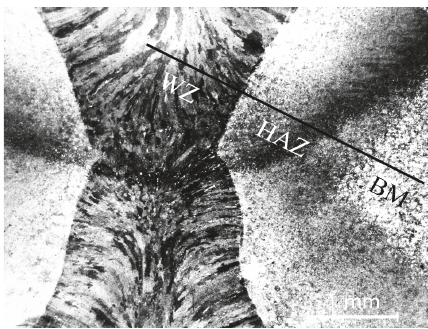
Figure 2: Cross section macro-images of the weld